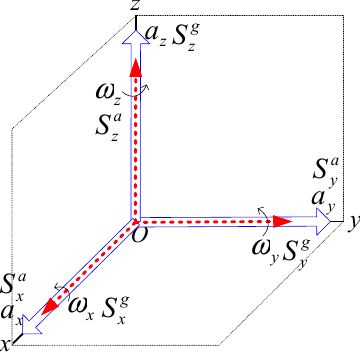
Figure 5. Sensitivity axes of the gyroscope and accelerometer.